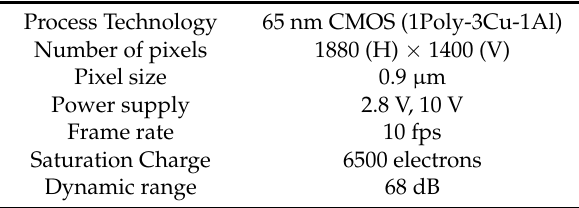
Figure 3. A schematic of the pixel circuit. Table 1. Specification of the OPF imager used in the present work.